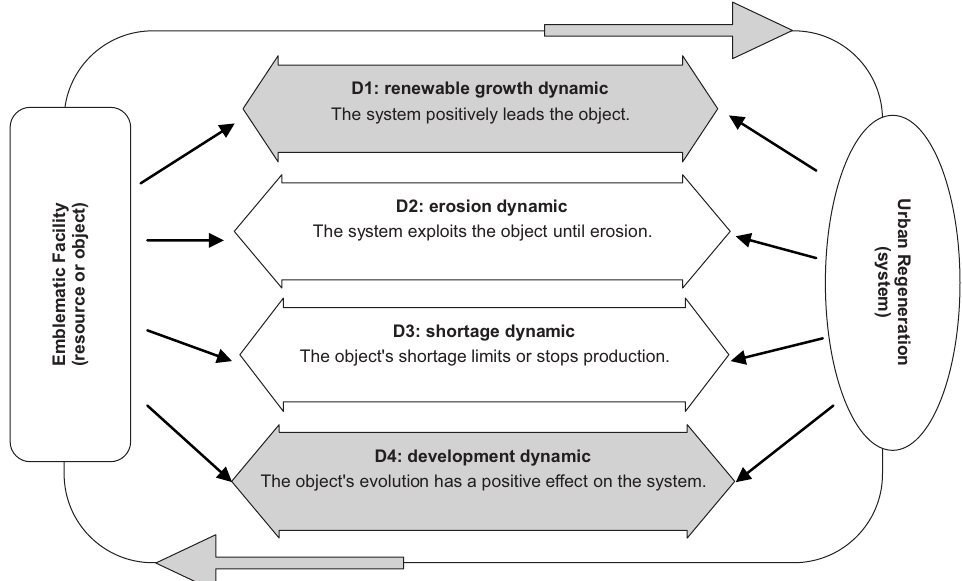
Fig. 2. Potential dynamics between an object (EF) and the production (urban)